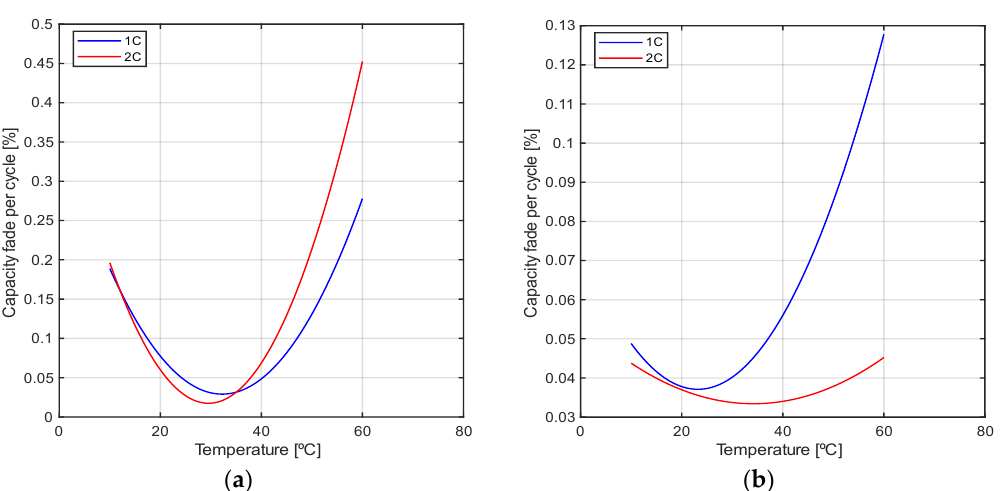
Figure 8. Equivalent degradation model of the NMC (a) and NCA (b) cells.